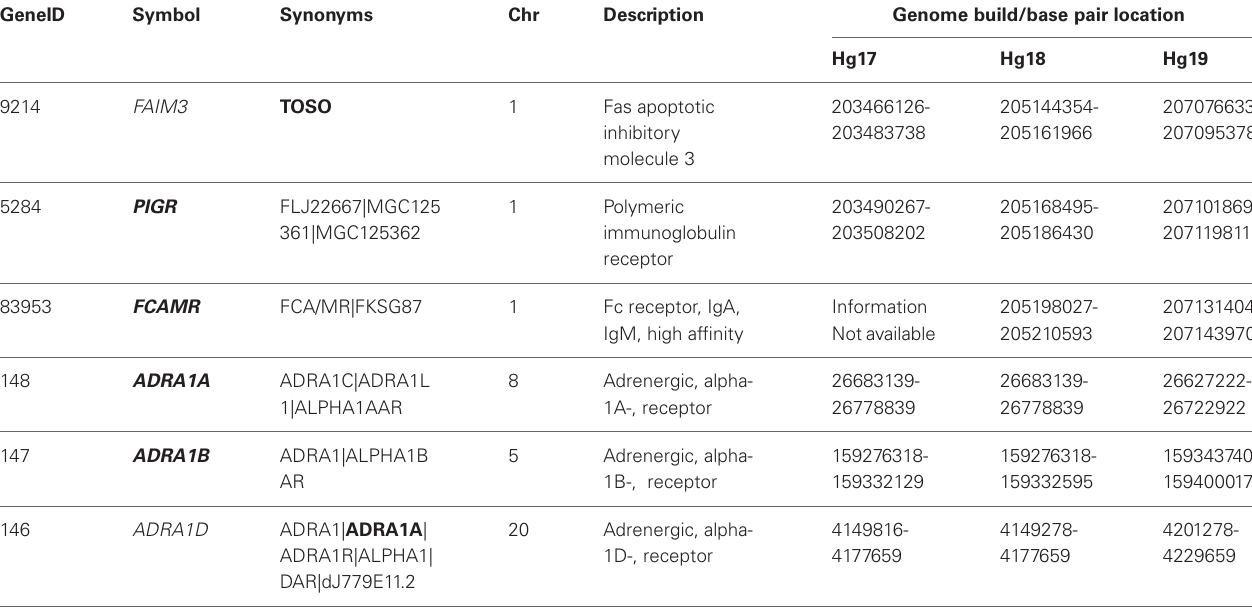
Table 1 | Inconsistency in gene “names” and locations. GeneID